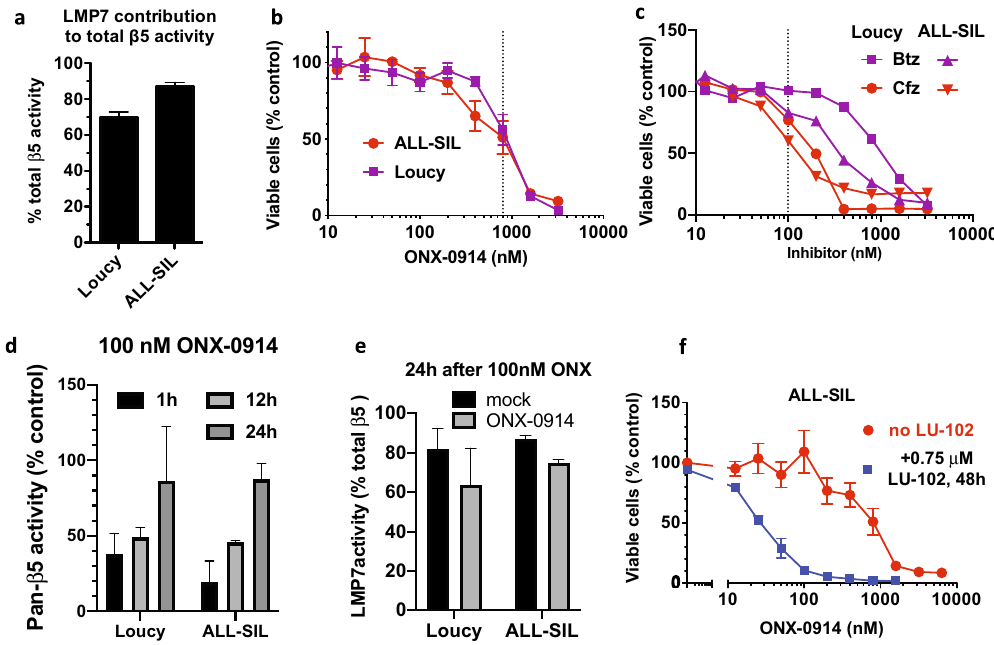
Figure 7. T-ALL cells are sensitive to pharmacologically relevant concentrations of ONX-0914. ( a ) LMP7 contribution to the cleavage of Suc-LLVY-amc was determined using LU-015i. ( b , c ) Cells were treated with ONX-0194 (n = 3–4), Btz, or Cfz (n = 2–3) for 1 h, and then cultured in the absence of inhibitors for 48 h, followed by an Alamar Blue assay. Dashed lines indicate concentrations that cause in vivo achievable levels of proteasome inhibition. ( d , e ) Recovery of a total ß5 (LMP7 + PSMB5) activity after 1 h treatment and LMP7 contribution to the recovery was determined as on Fig. 5 (n = 2–3). ( f ) ALL-SIL cells were treated with ONX- 0914 for one hour, followed by 48 h treatment with 0.75 μM LU-102, and viability was measured with Alamar Blue (n =